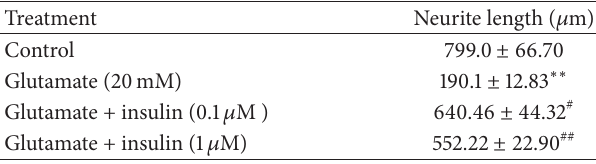
Table 5: Effect of treatments on length of neurites.